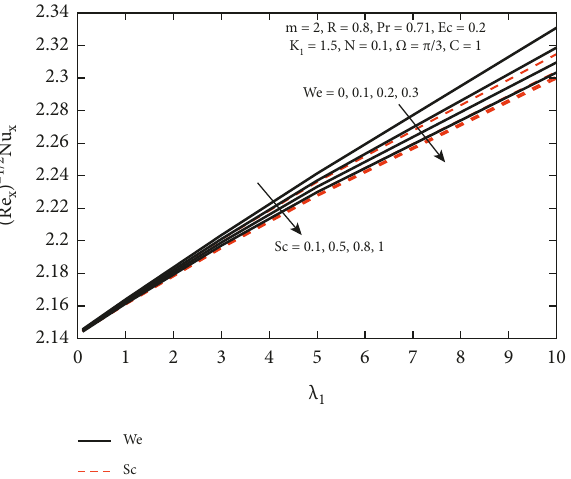
R for growing values of We and Sc. ux / ex (cid:27)(cid:27)(cid:27) (cid:26)